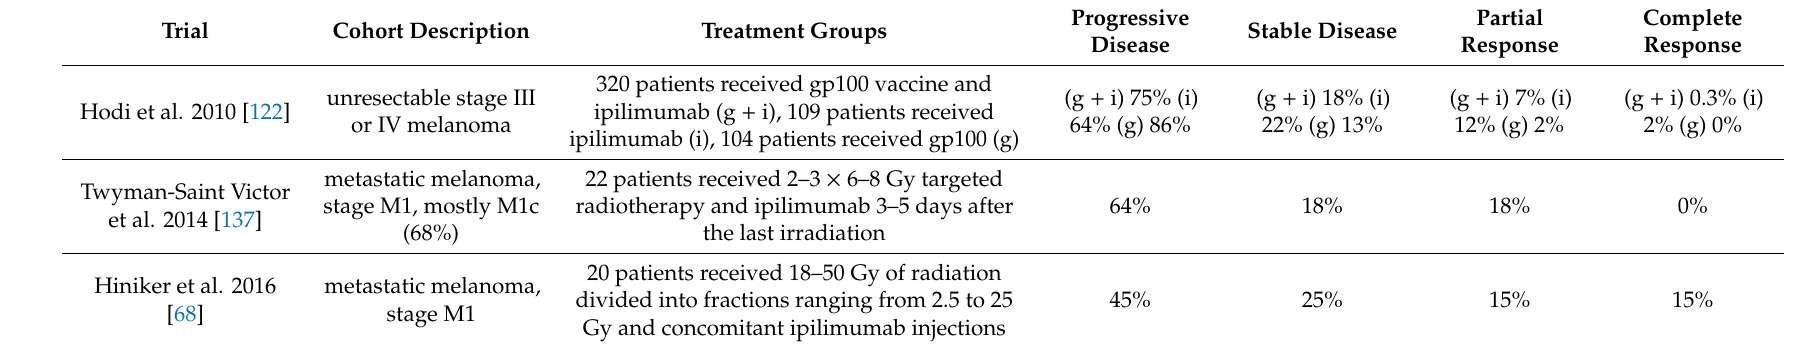
Table 2. Prospective clinical trials exploring ipilimumab with or without radiotherapy in metastatic